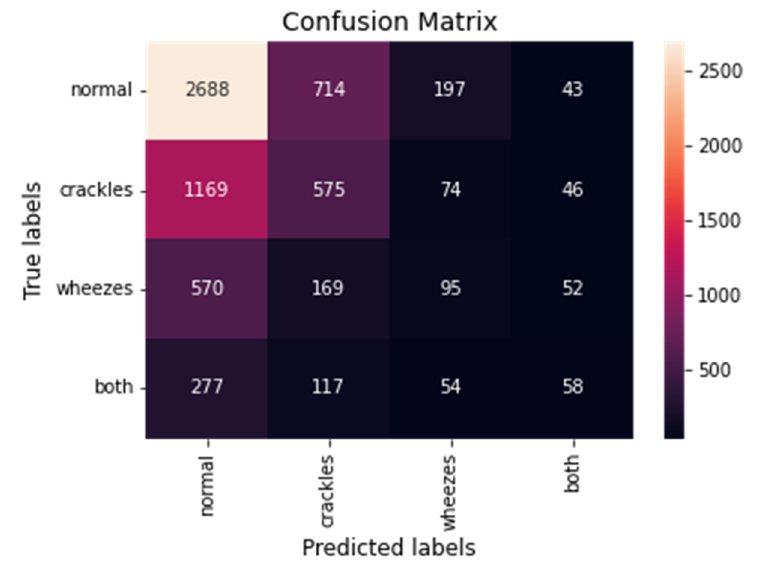
Figure 5. The overall confusion matrix for the CNN-LSTM model with FL.